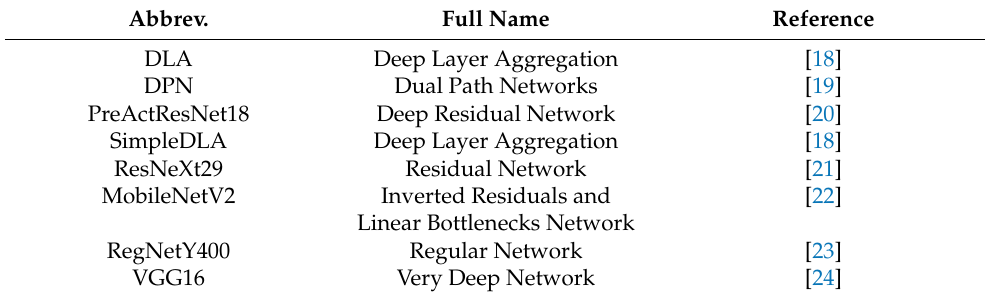
Table 2. Experimental DNN architectures and their performance when applied to the CI- FAR10 dataset.